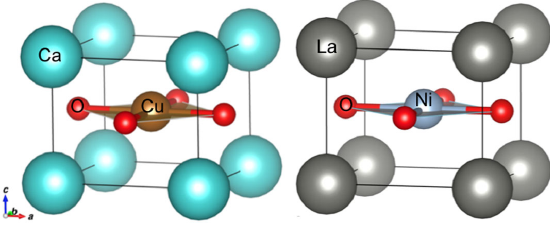
FIG. 1. Crystal structure of CaCuO 2 (left) and LaNiO 2